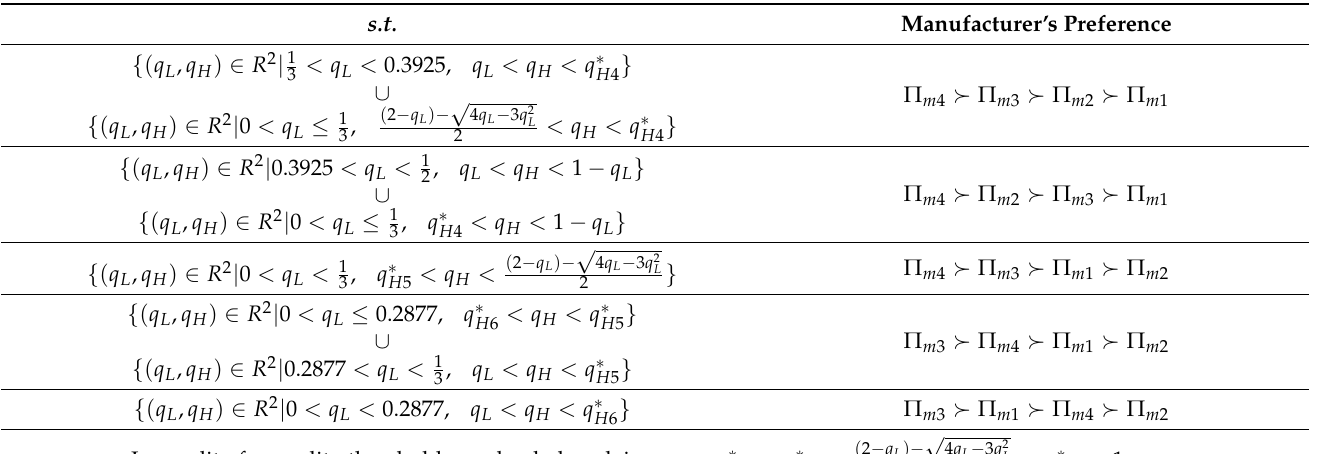
Table 3. Manufacturer’s preference for channel structures in different mass intervals. s.t.